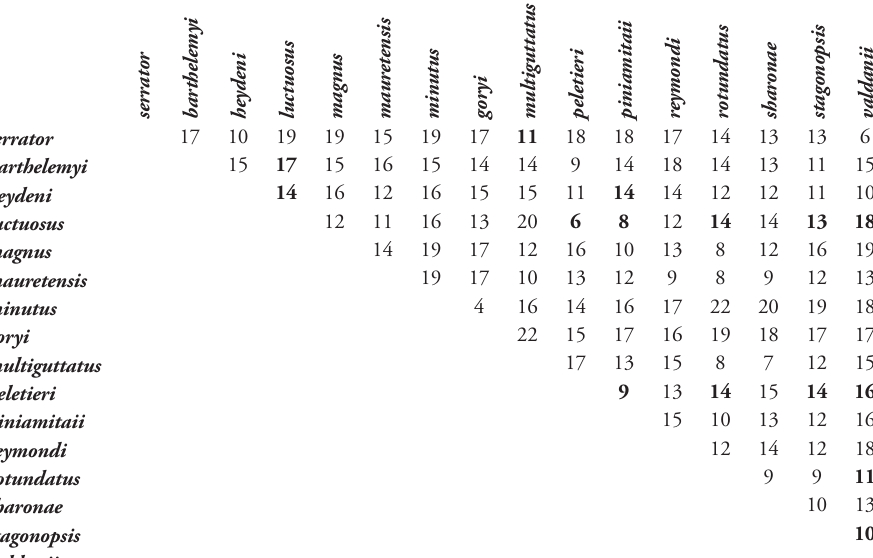
Table 1. Matrix of the sum of diagnostic characters for species delimitation. Bold marked are sympa- tric taxon pairs.